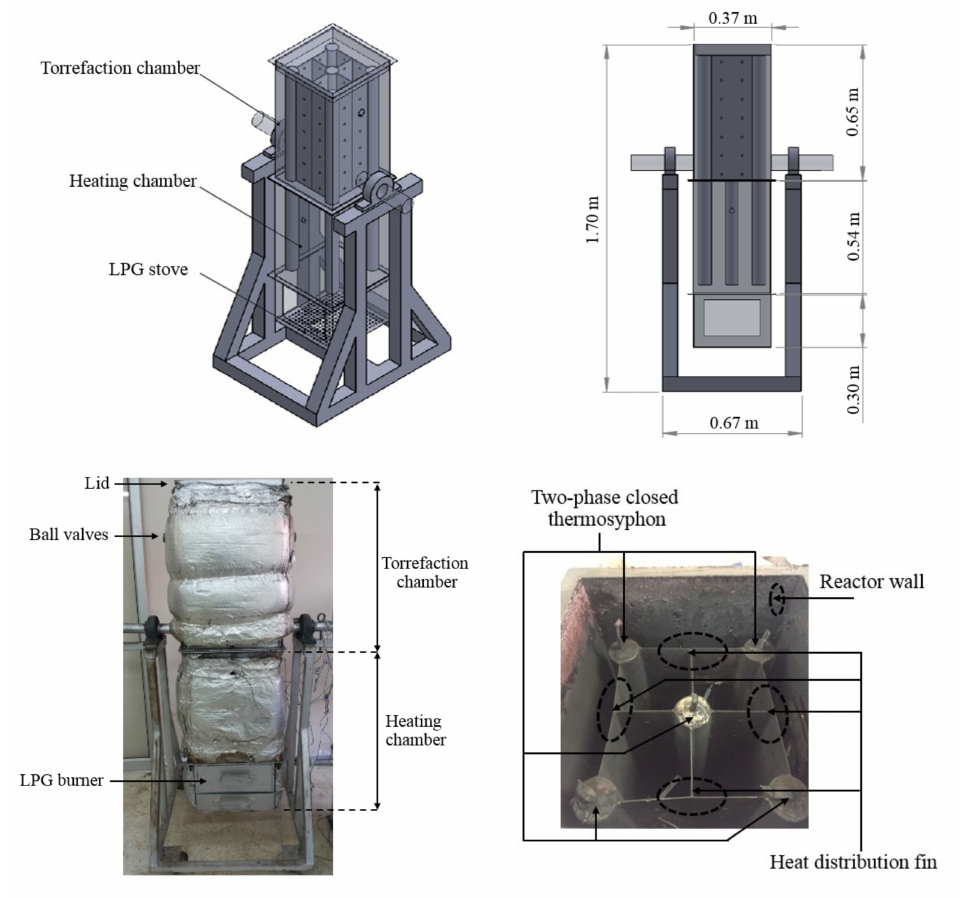
Figure 1. Thermosyphon-fixed bed torrefaction